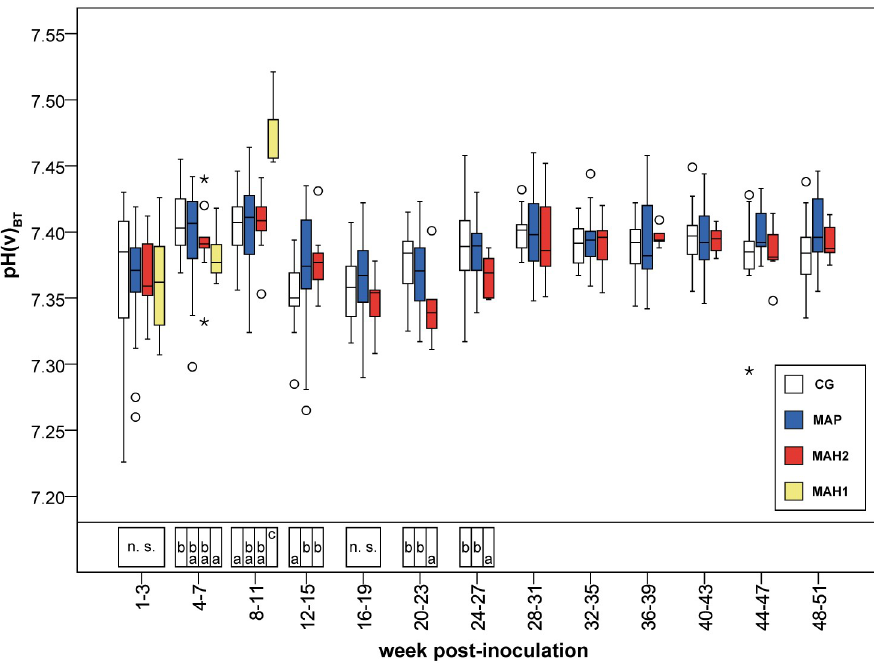
Fig 2. Measured pH values assessed in venous blood, corrected for actual body temperature. CG, control group. MAP, group infected with Mycobacterium avium subsp. paratuberculosis . MAH 1, sub-group infected with Mycobacterium avium subsp. hominissuis with acute, severe form of infection. MAH 2, sub-group with chronic form of infection. BT, body temperature (rectally measured before each blood collection). Different letters indicate significant differences between groups within one period (Mann-Whitney U -test, P < 0.05). n.s., no significant differences between groups in the given period. From 28 th week onwards Mann-Whitney U -test was not performed due to reduced numbers of observations. Significant differences within groups (Friedman test, P < 0.05) from 1 st -3 rd to 24 th -27 th wpi are given in S3–S5, and S10 Tables.